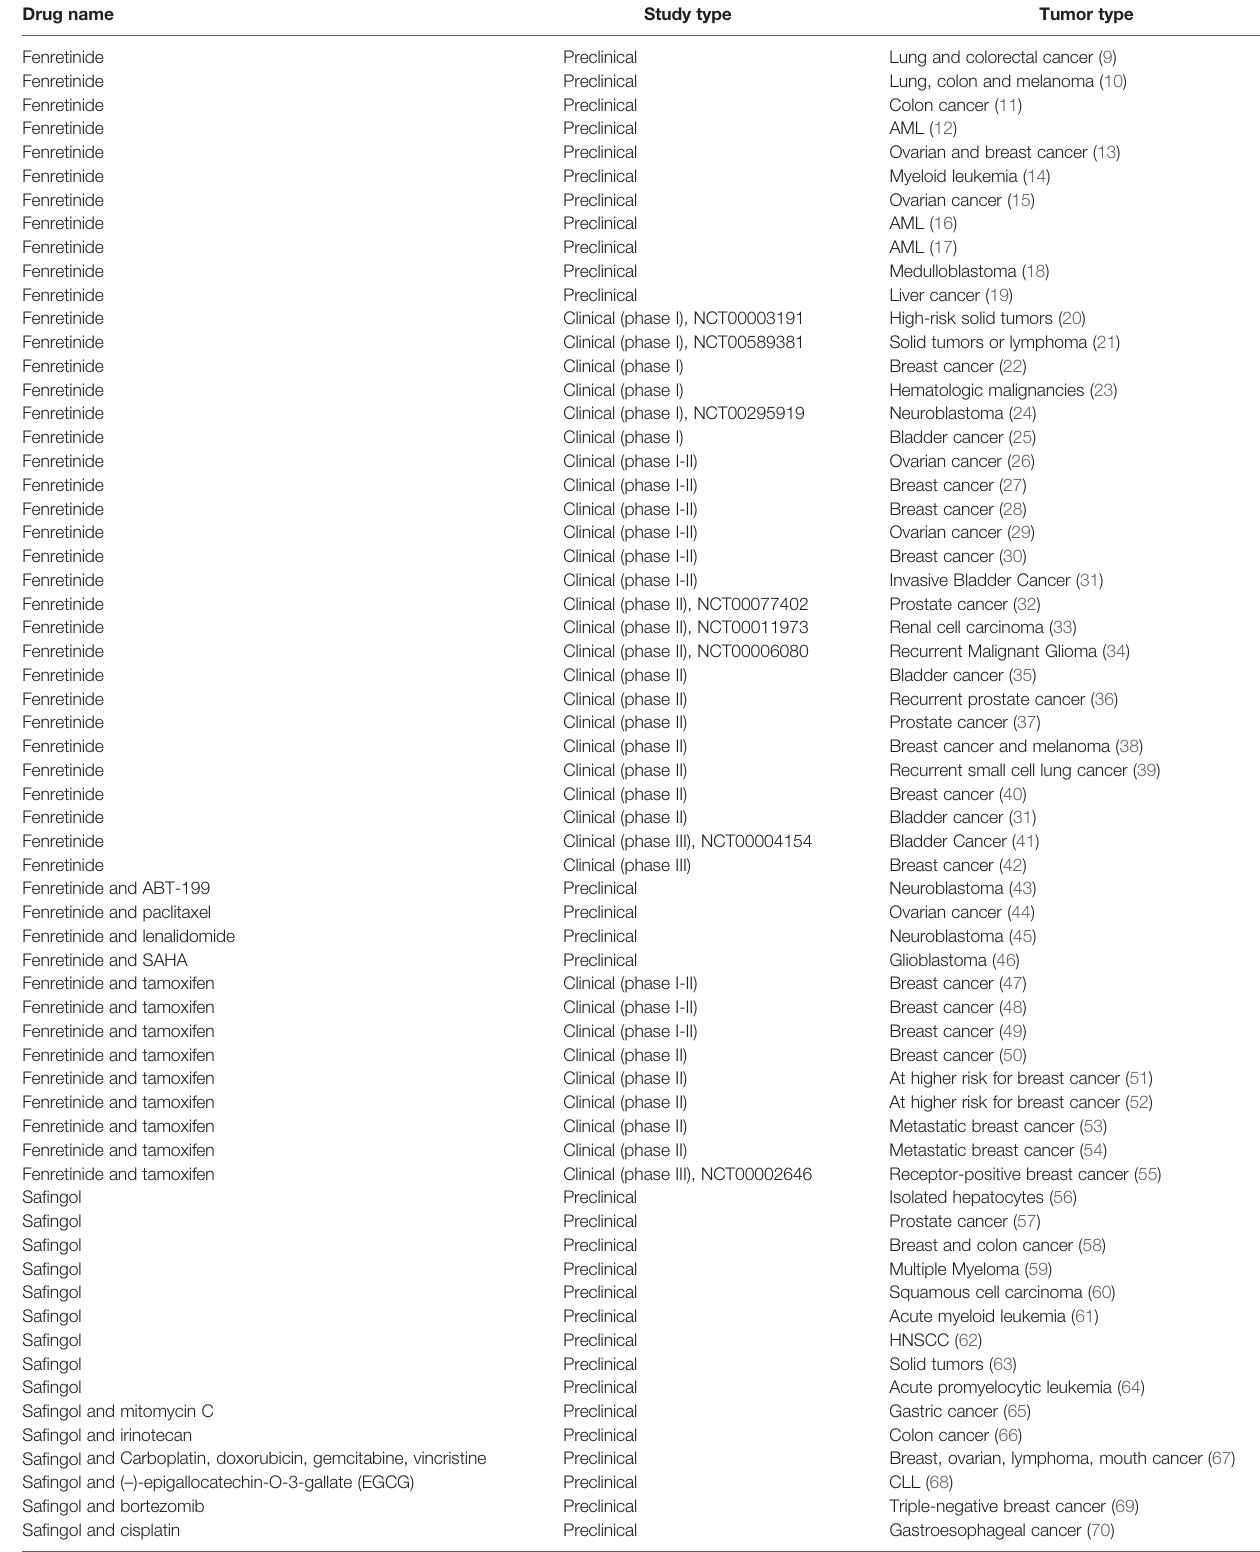
TABLE 1 | Summary of preclinical and clinical studies of inhibitors/modulators of sphingolipids and